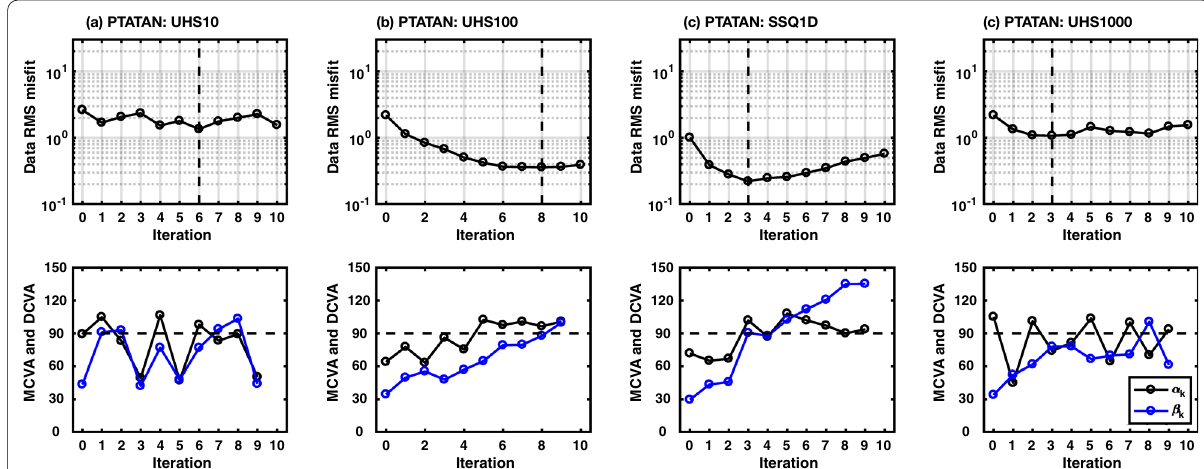
Fig. 14 dRMS (top, black solid curves with symbols) and the MCVA (bottom, black) and DCVA (bottom, blue) at each iteration step obtained from inverting PTATAN using a UHS10, b UHS100, c SSQ1D, and d UHS1000 as the initial model. The dashed line in each of the dRMS plots indicates the iteration step, where the dRMS is